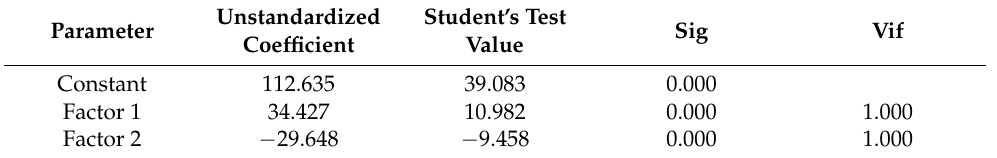
Table 12. Regression coefficients of the